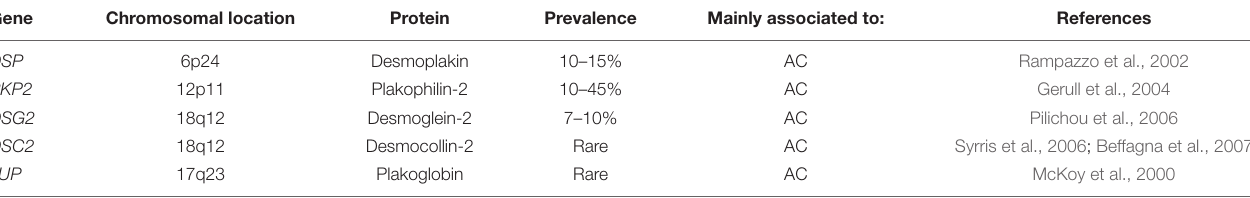
TABLE 1 | Desmosomal genes associated to AC.